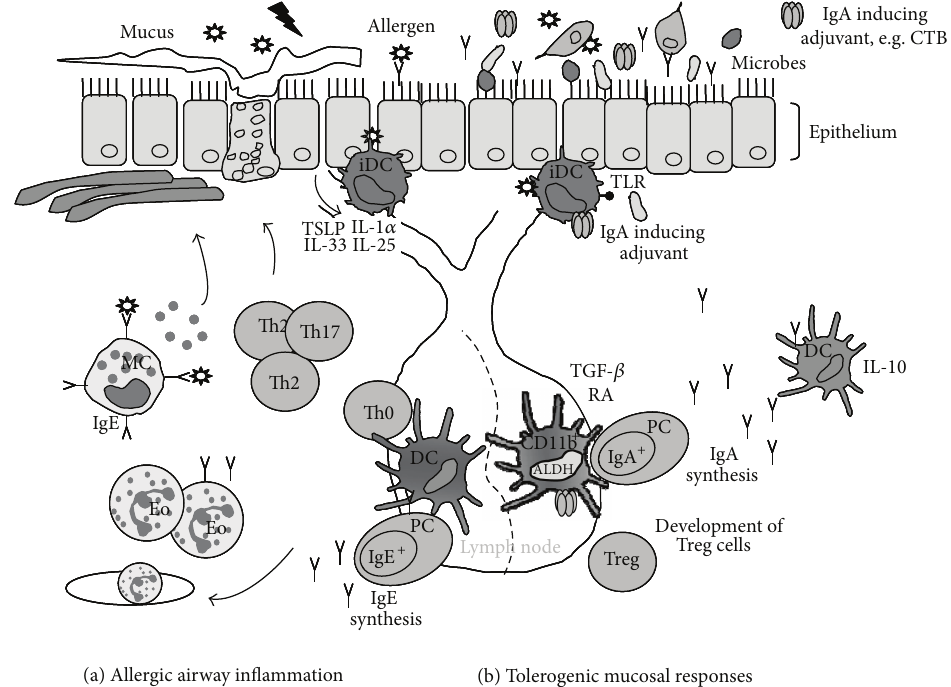
Figure 3: Crosstalk between epithelial cells and dendritic cells (DCs) in the lungs determines the balance between immunity and tolerance. (a) Allergen exposure in susceptible individuals may result in epithelial damage, initiating a cascade of immunological events leading to inflammation and allergic symptoms. (b) In contrast, IgA-inducing agents, such as CTB, alone or in combination with microbial exposure, prevent the development of allergic inflammation, by protecting the epithelial barrier and by effecting the function of various immune cells via DC. Immature DC (iDC), T helper 2 cell (Th2), T helper 17 cell (Th17), eosinophil (Eo), masT-Cell (MC), and plasma cell